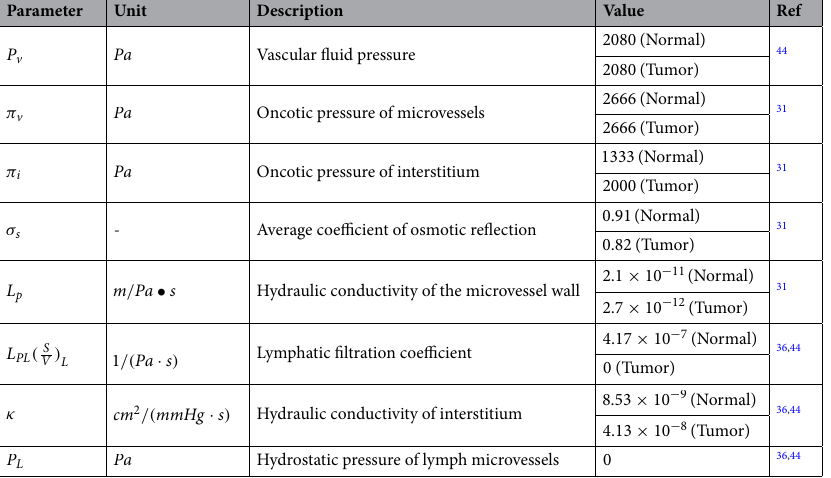
Table 2. Parameters of interstitial fluid transport.